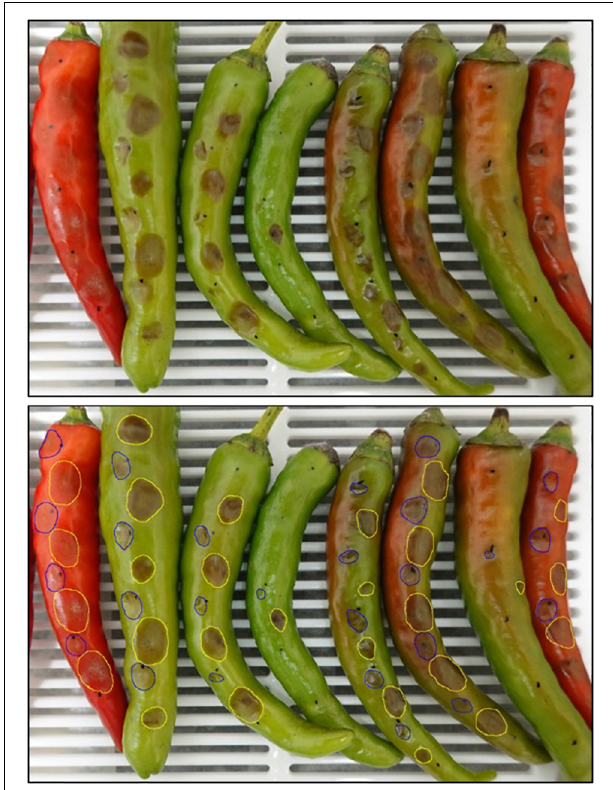
FIGURE 10 | Anthracnose lesions caused by Coll-365 and its transgenic strain X-1 on Capsicum annuum cv. Fushimi-amanaga 5 days after paired inoculation. The photos were used to show the inoculation, symptom development and lesion size calculation in this study. The upper photograph shows the original lesions and the lower photograph shows the marked lesion sizes for Spot image calculation. The inoculation was performed by dropping 5 µ l spore suspensions of Coll-365 on the left side (marked with blue color) and a transgenic strain on the right side (marked with yellow color) of each